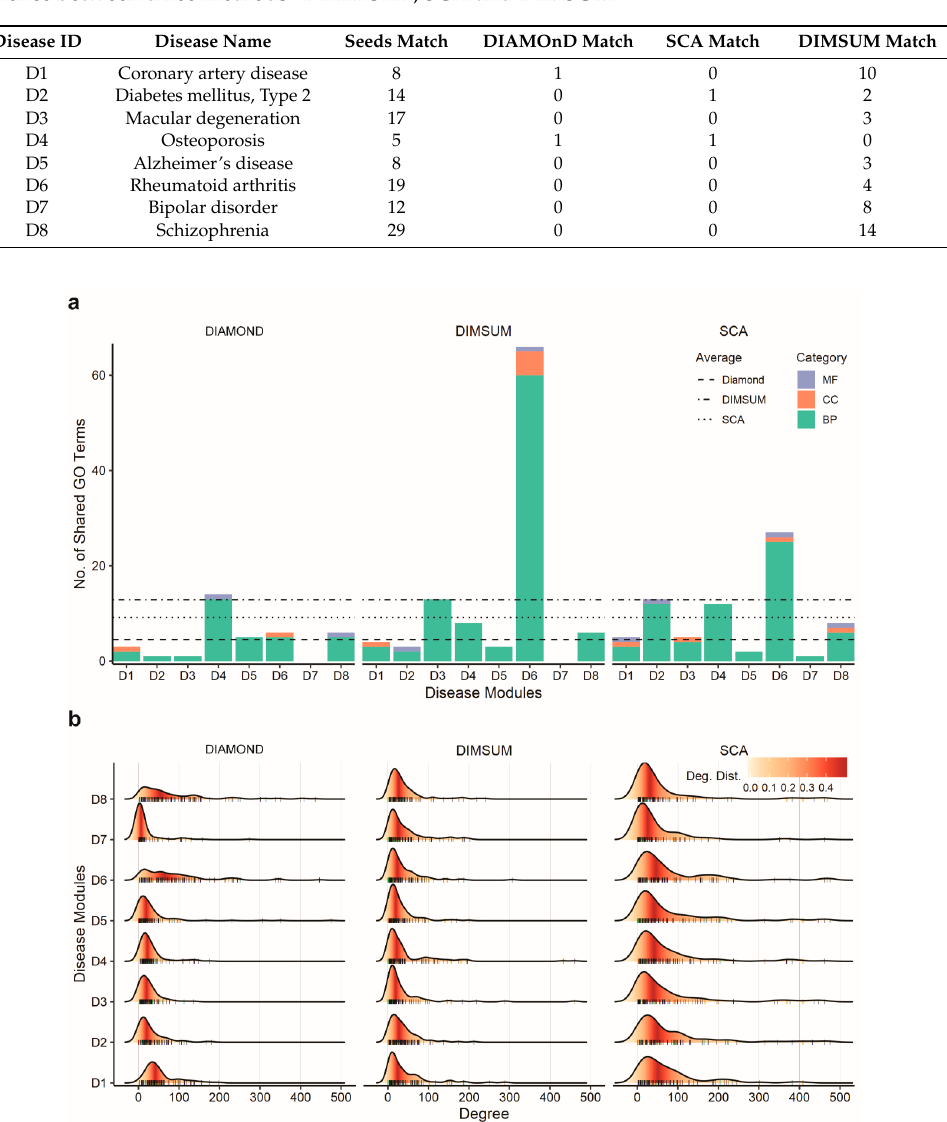
Table 1. Comparison of the number of disease associated genes in the detected modules with literature evidence between three methods: DIAMOnD, SCA and DIMSUM.